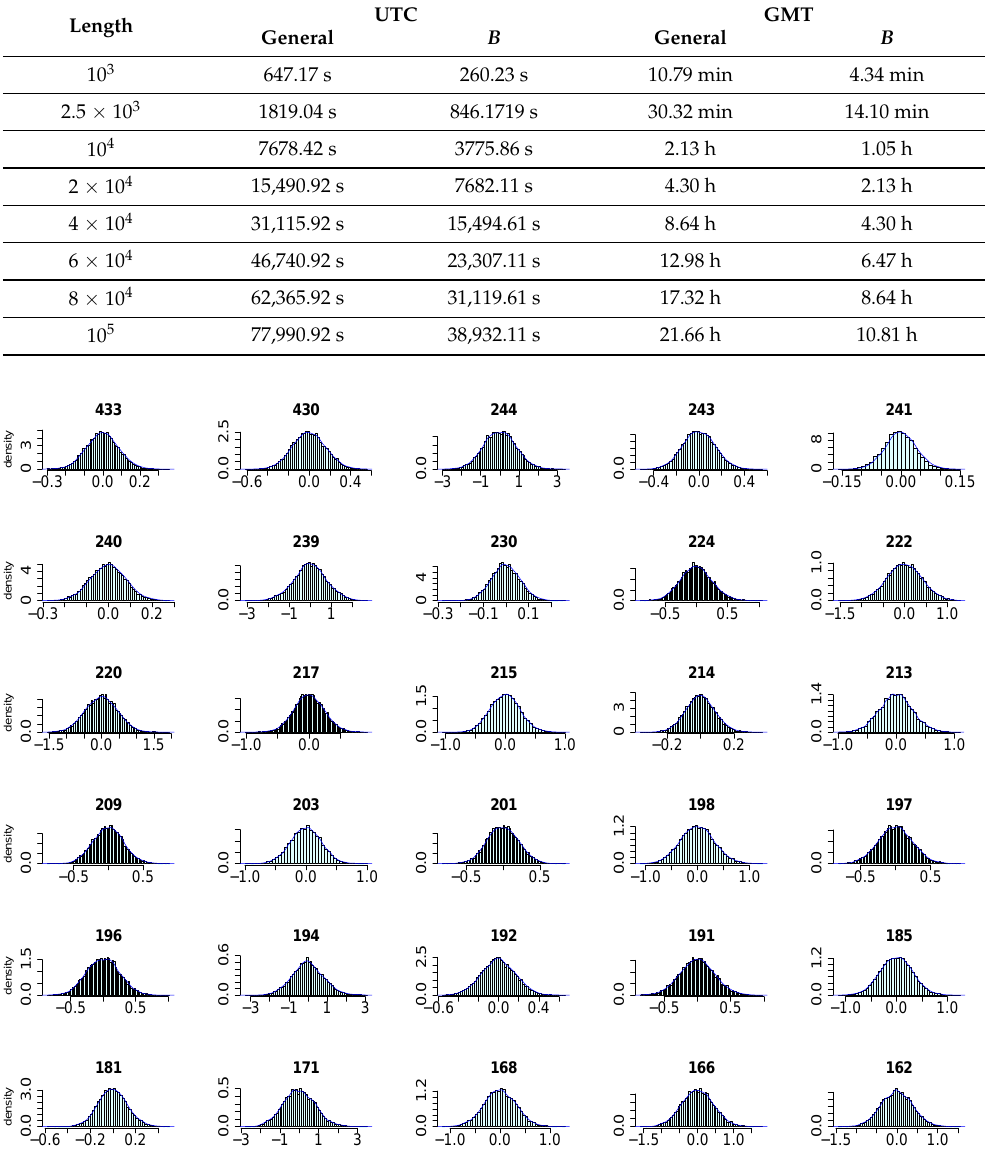
Table 2. Time period in UTC and GMT associated to each length in (6). The times are divided in those for the 6 buoys in B and the rest of 53 buoys, which are labelled by general.